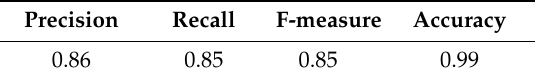
Table 1. Analysis of the picked horizons.